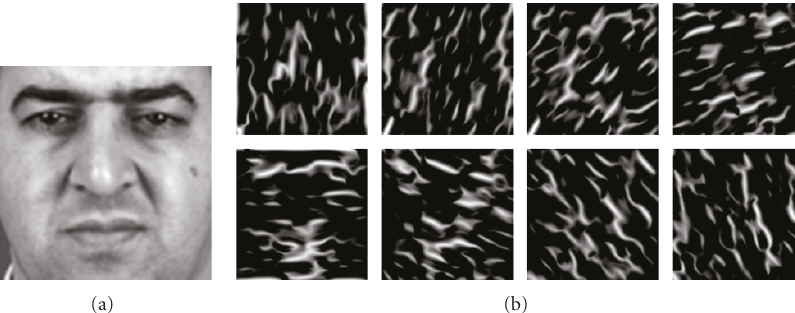
Figure 7: An example of all OGPCIs: the original face image (a), the OGPCIs (for r = 8) (b), which in their downsampled and normalized form constitute the augmented Gabor phase congruency